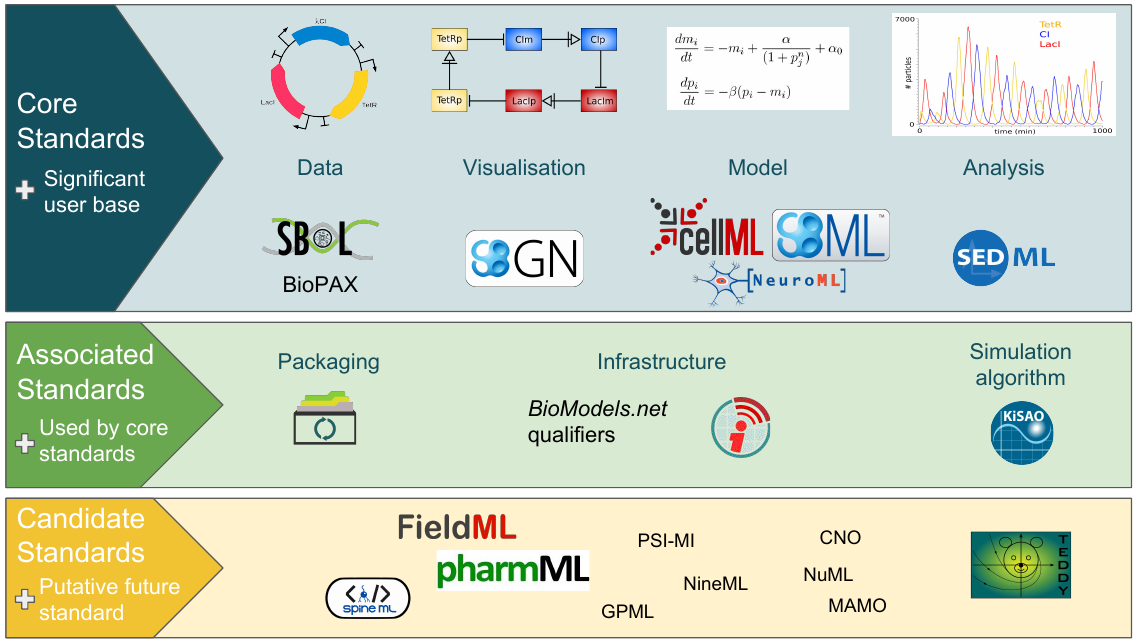
Figure 1: COMBINE standards and associated standardisation